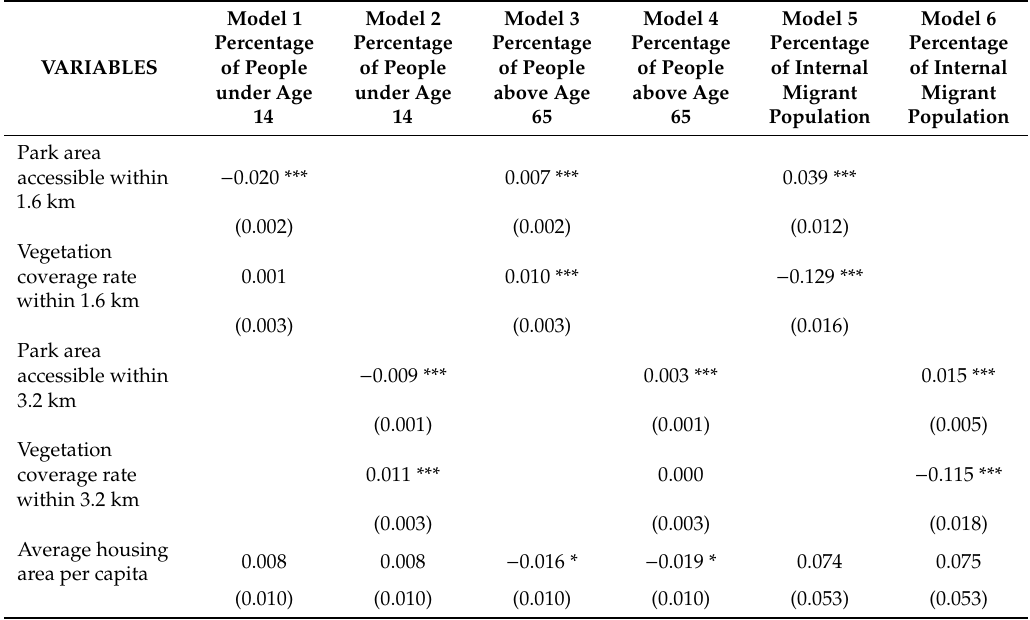
Table A3. Sensitive analysis: regression for entire country using townships o ffi cially coded as